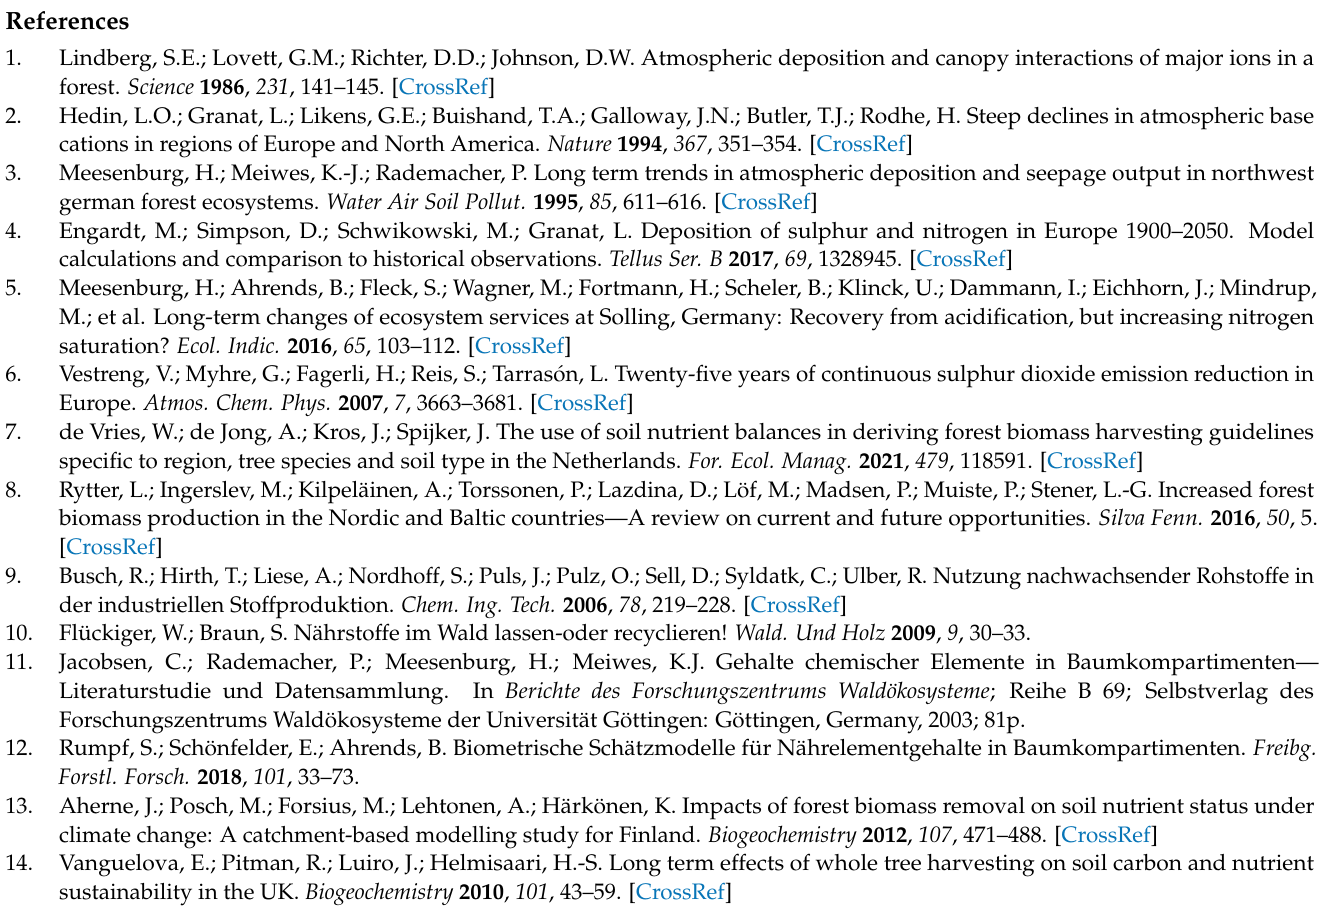
Figure A7. Spatial distribution of Mg balances calculated with measured NFSI data ( A ) and regionalized Mg balances at NFI sites ( B ). Black lines are boundaries of model regions (see Figure 2).